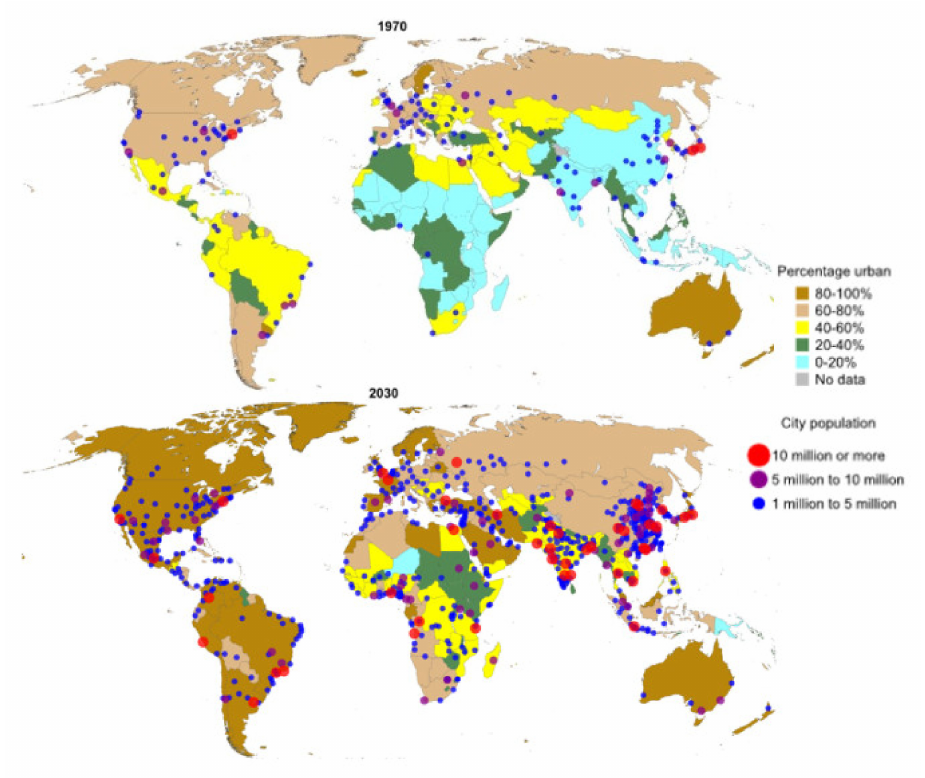
Figure 3. The projected growth of urban population and cities in 2030 compared to 1970. Source: https://population.un.org/wup/Maps/ (accessed on 2 August 2021). Urban areas are the focal point of economic activity in most areas of the globe.